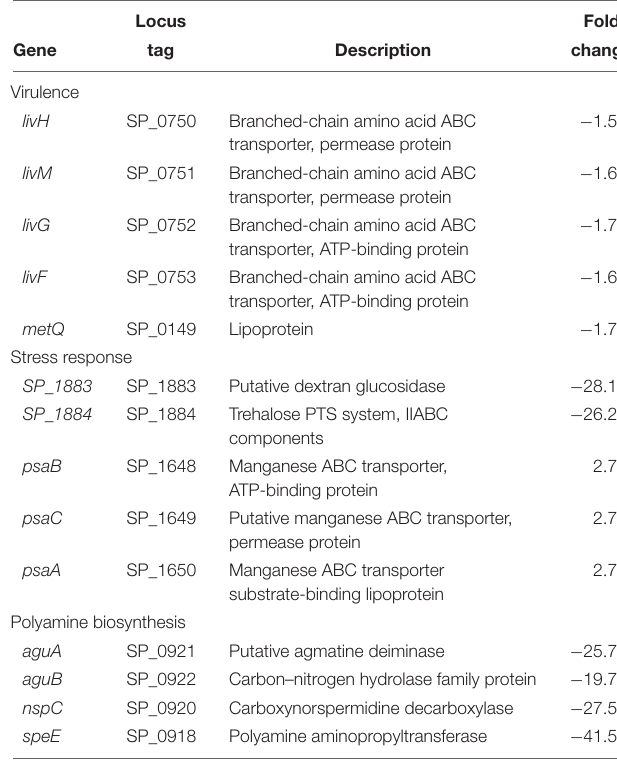
TABLE 3 | Differentially expressed genes of known virulence factors, stress response, and polyamine biosynthesis in (cid:49) cadA . Locus Fold Gene tag Description change